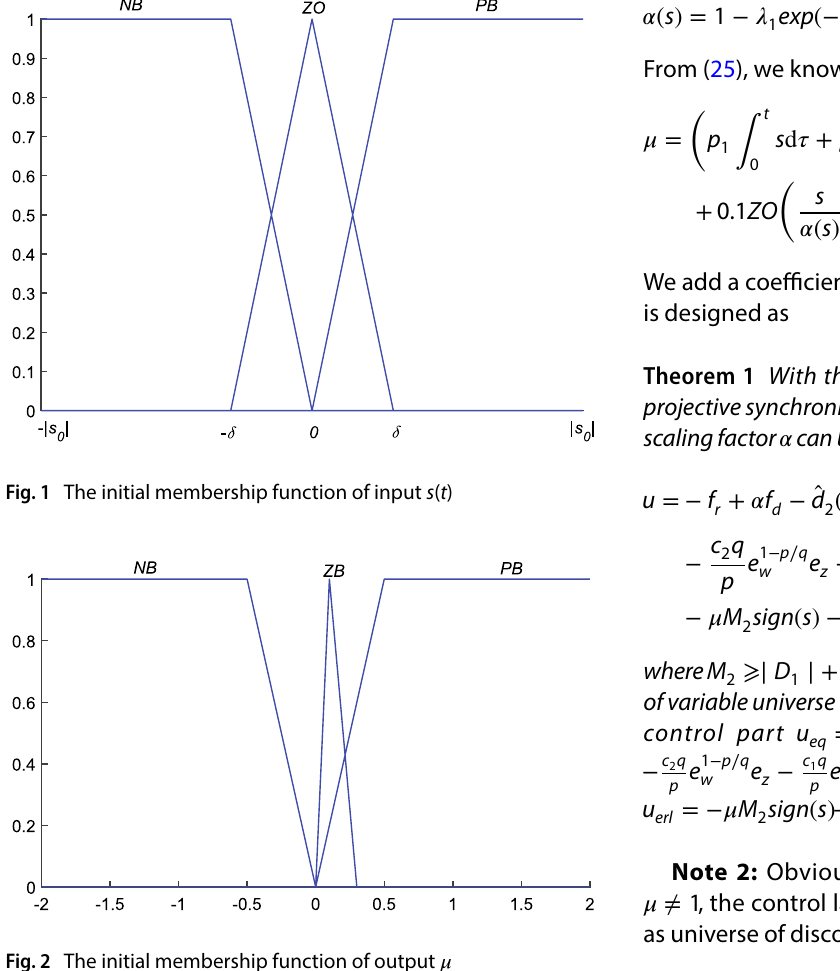
Fig. 2 The initial membership function of output